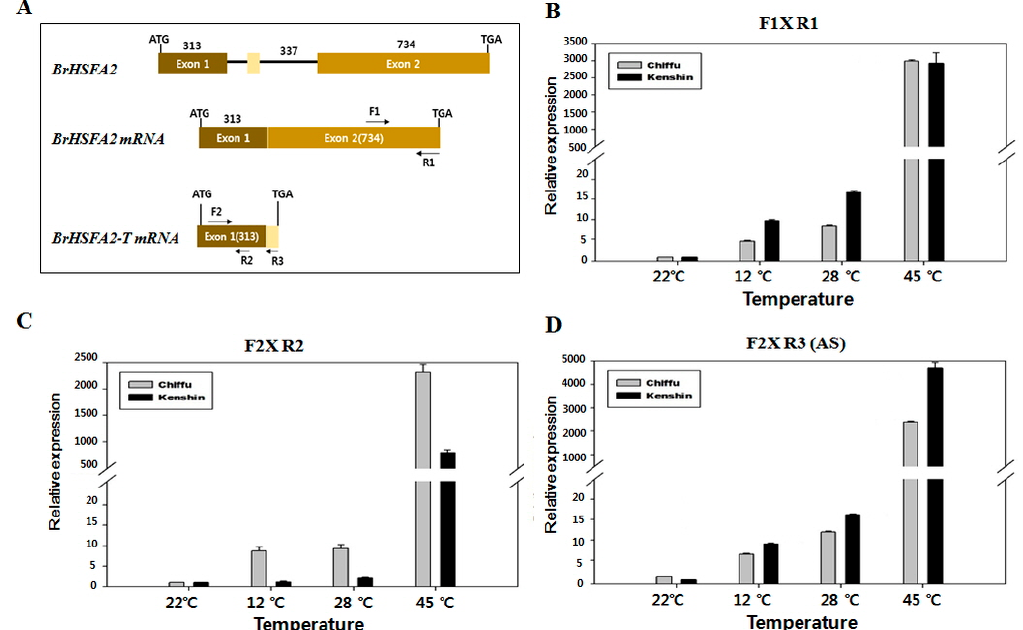
Figure 6. BrHSFA2 expression in Chiifu and Kenshin during warming and heat shock treatments. qRT-PCR was performed with primer sets described in Table S1 and data analysis was carried out using qPCR value of three replicates. ( A ) Genomic organization of BrHSFA2 and possible mRNAs with primer positions indicated; ( B ) Full-length BrHSFA2 mRNA levels; ( C ) BrHSFA2 mRNA containing both full-length and truncated (alternatively spliced) forms; ( D ) Truncated form of BrHSFA2 mRNA.